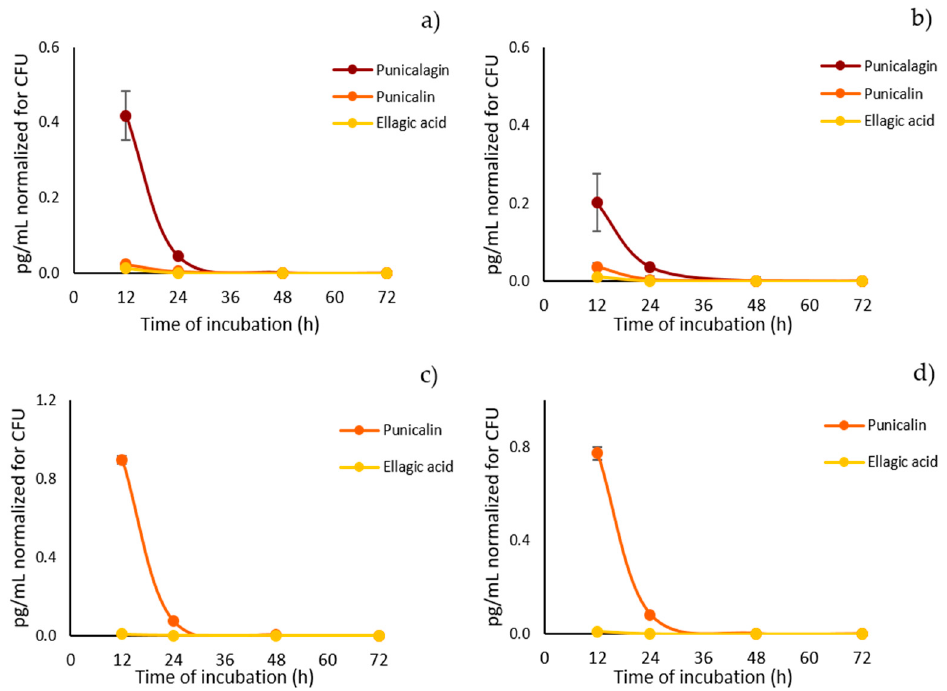
Figure 3. Trend of pomegranate polyphenols in Candida albicans SC 5314 and C. albicans 1 lysates. C. albicans SC 5314 was incubated with punicalagin ( panel a ) and punicalin ( panel c ); the clinically isolated C. albicans 1 was incubated with punicalagin ( panel b ) and punicalin ( panel d ). The amounts of pomegranate polyphenols detected in cell lysates are expressed as pg/mL and they were normalized for the number of colony forming units (CFU) at the different incubation time.